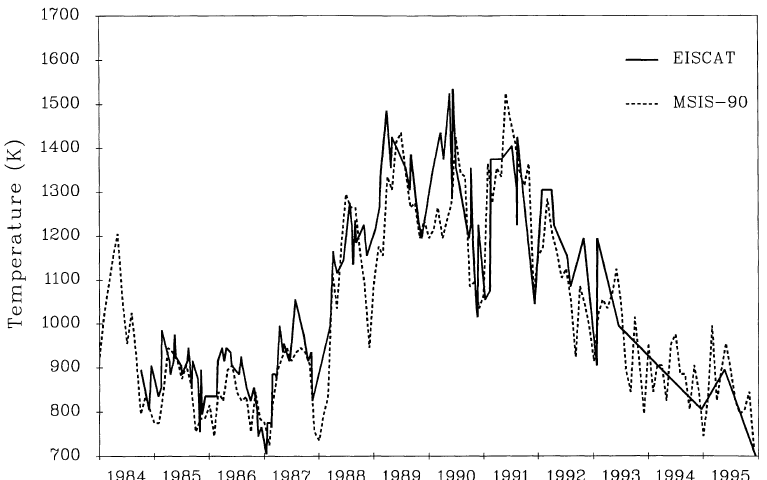
Fig. 1. Variation of the unperturbed ion temper- ature, derived from the EISCAT CP-1 and CP-2 observations at 312 km altitude ( solid line ). The dotted line indicates the variation of the thermos- pheric temperature at the same altitude, from the